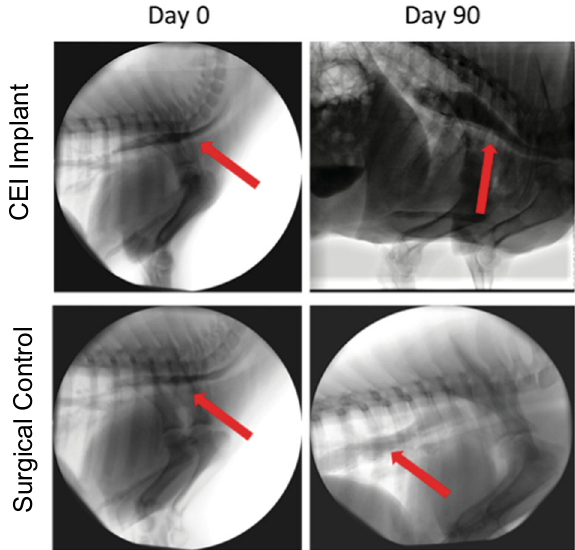
Fig. 4 Representative barium swallow esophagram images from a CEI recipient and a surgical control animal. Esophagram analysis following a barium swallow test from Control and CEI Test animals at 30- and 90 days post surgery (red arrows indicate barium in